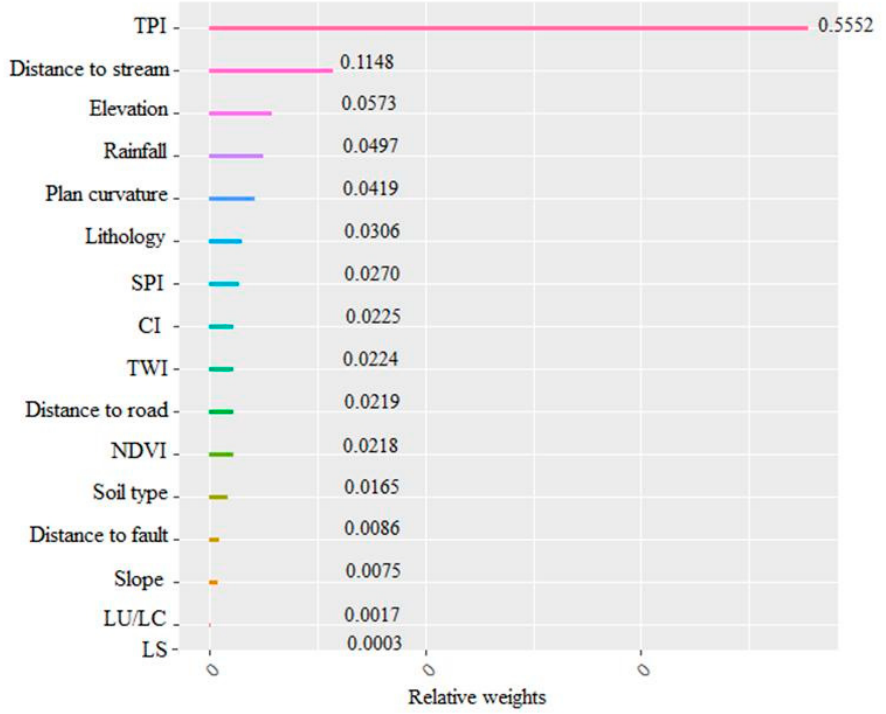
Figure 9. The relative importance of landslide conditioning factors using boosted regression tree model.